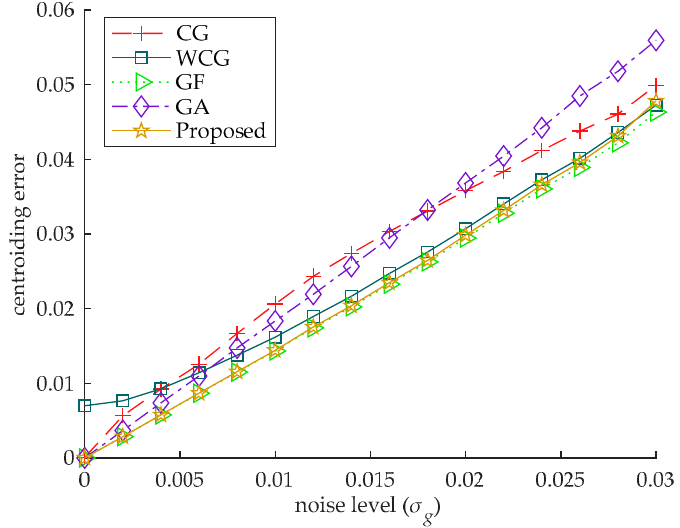
Figure 6. The centroiding error under different level of the noise. The centroiding error of the proposed algorithm is almost the same as that of the GF, less than that of other algorithms under all levels of the noise.